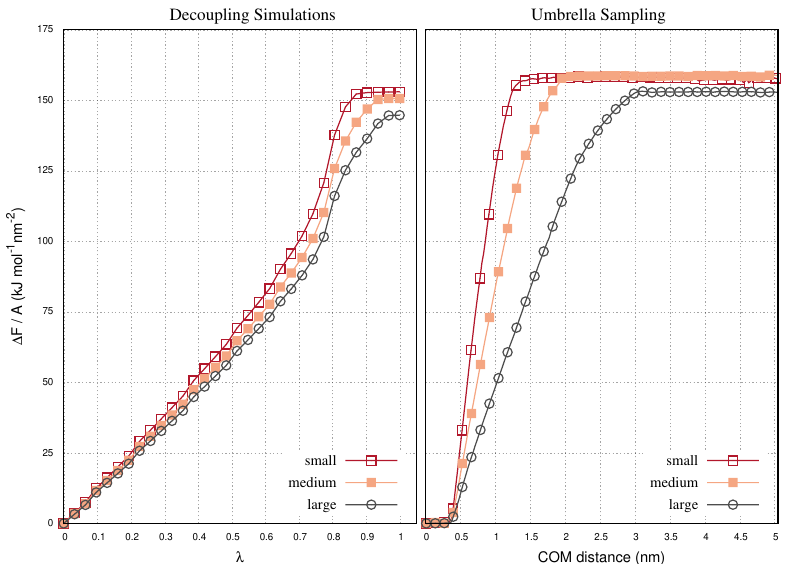
Figure 4. ( Left ) Exfoliation free energies of bilayer graphene samples with small, medium and large size, computed by decoupling simulations. The energies are shown as a function of the decoupling parameter λ , and computed by subtracting the relevant curves shown in the panels of Figure 3, based on the expression ∆ F AB = ( F B − F C ) − ( F C − F A ) . ( Right ) Exfoliation free energy of the same bilayer graphene samples computed by umbrella sampling. The energies are shown as a function of the interlayer distance as the one layer is pulled away from the other on the shear direction. The umbrella sampling simulations are performed in a previous work